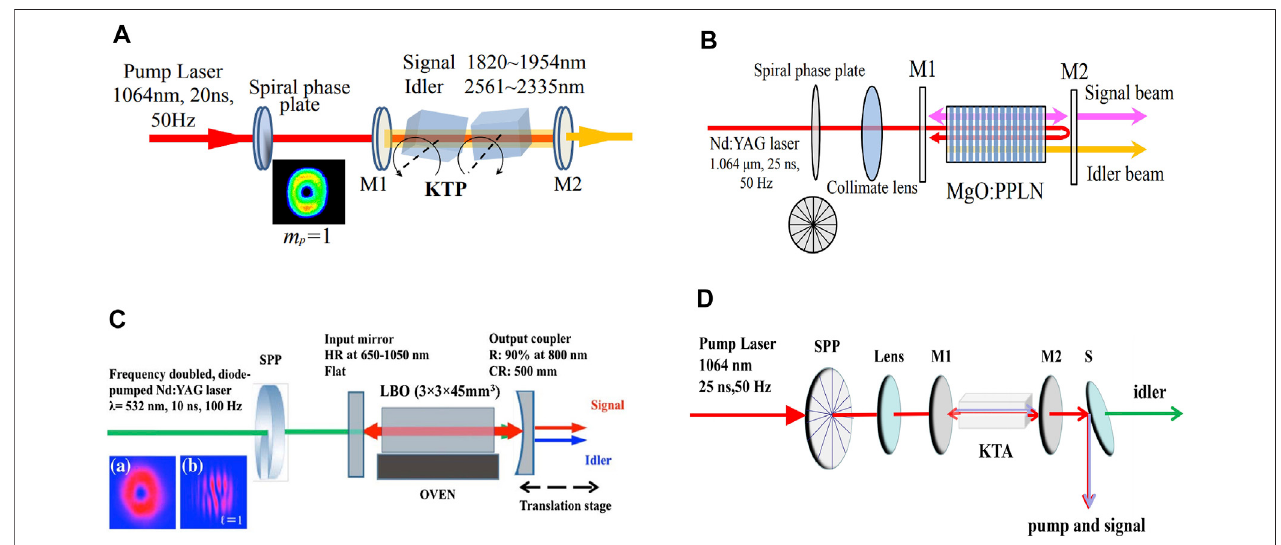
FIGURE11|(A) setupsofmid-infrared(6.3 – 12 μ m )vortexparametricgenerationwithwalk-offcompensatingdesignbasedontwoKTP[135]; (B) con fi gurationsof the tunable 3 μ m optical parametric vortex laser based on MgO: PPLN [136] (C) con fi gurations of the tunable vortex beam output with NCPM-LBO [140] (D) con fi gurations of the optical parametric oscillator for the vortex output based on KTA with the plane – plane cavity for selective topological transfer [142].